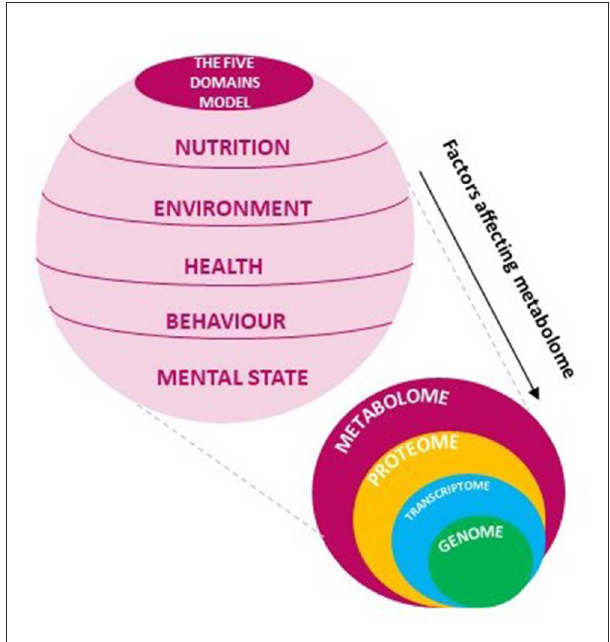
FIGURE1 The Five Domains model embodies all factors affecting changes in metabolome that may be explored with -omics sciences.